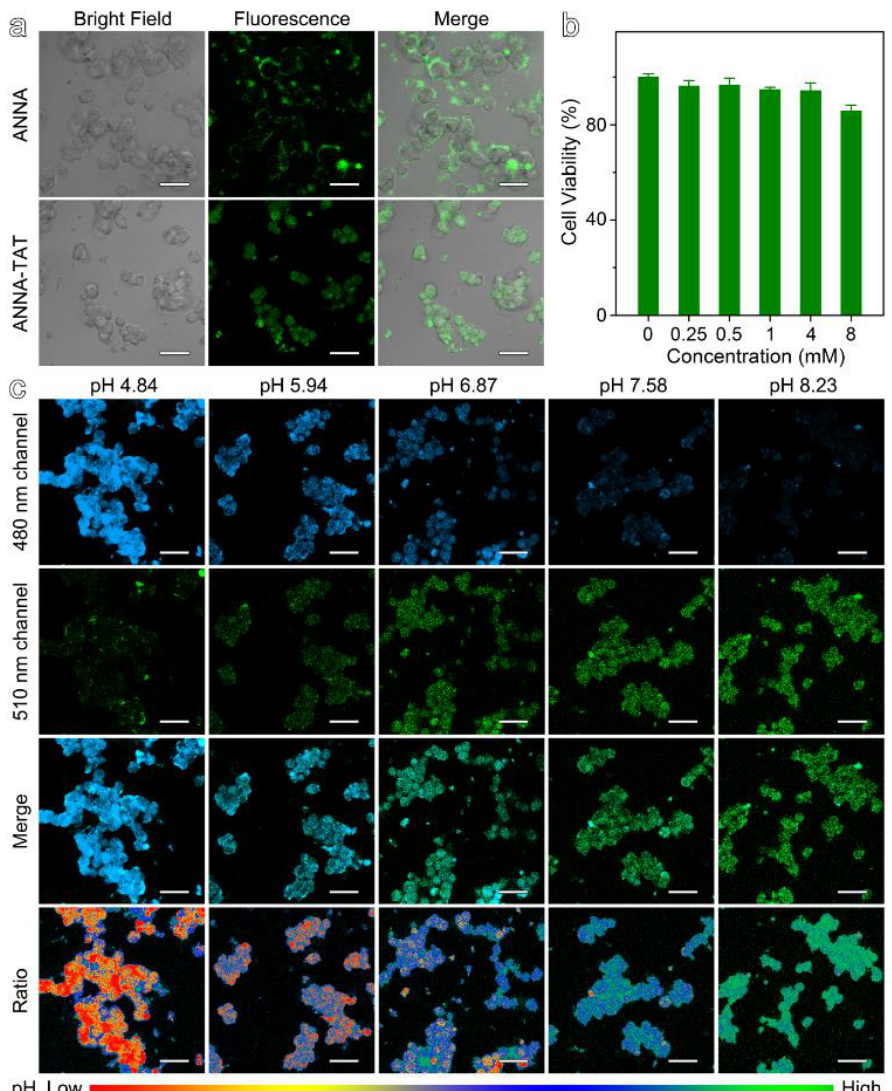
Figure 2. ( a ) Bright-field images and fluorescence images, together with merged images of LS180 cells incubated with TAT-ANNA and ANNA dye, respectively. ( b ) Viabilities of LS180 cells treated with TAT-ANNA probe. ( c ) Fluorescence images (collected at 465 – 490 nm and 510 – 550 nm for two channels), merged images, and ratio images of LS180 cells incubated with TAT-ANNA in buffer solutions with different pH values. The scale bars of (a) and (c) correspond to 10 μm.